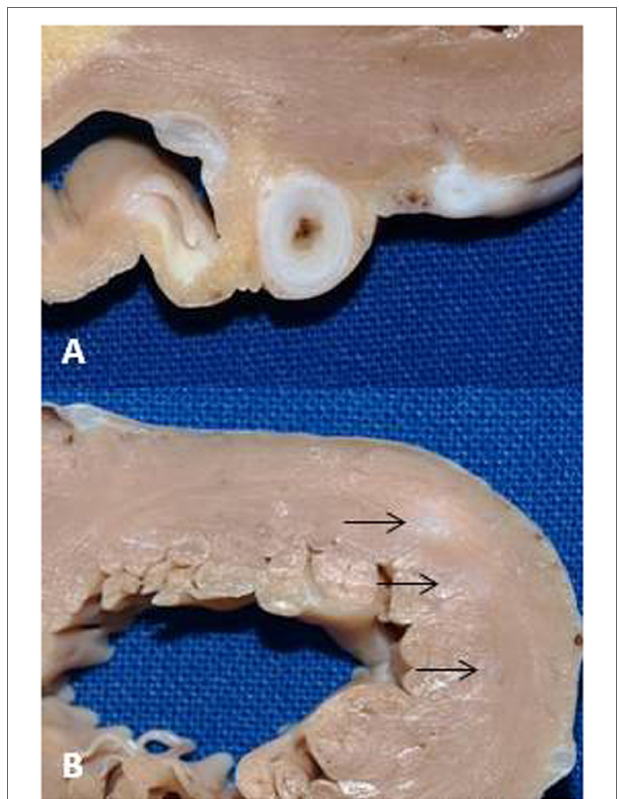
FIGURe 4 | (a) Cross-section of the proximal region of the left anterior descending artery showing the excessive thickening of the coronary artery wall at the level of aneurysm. (B) Multiple infarctions were presented in the left ventricular wall (arrows).